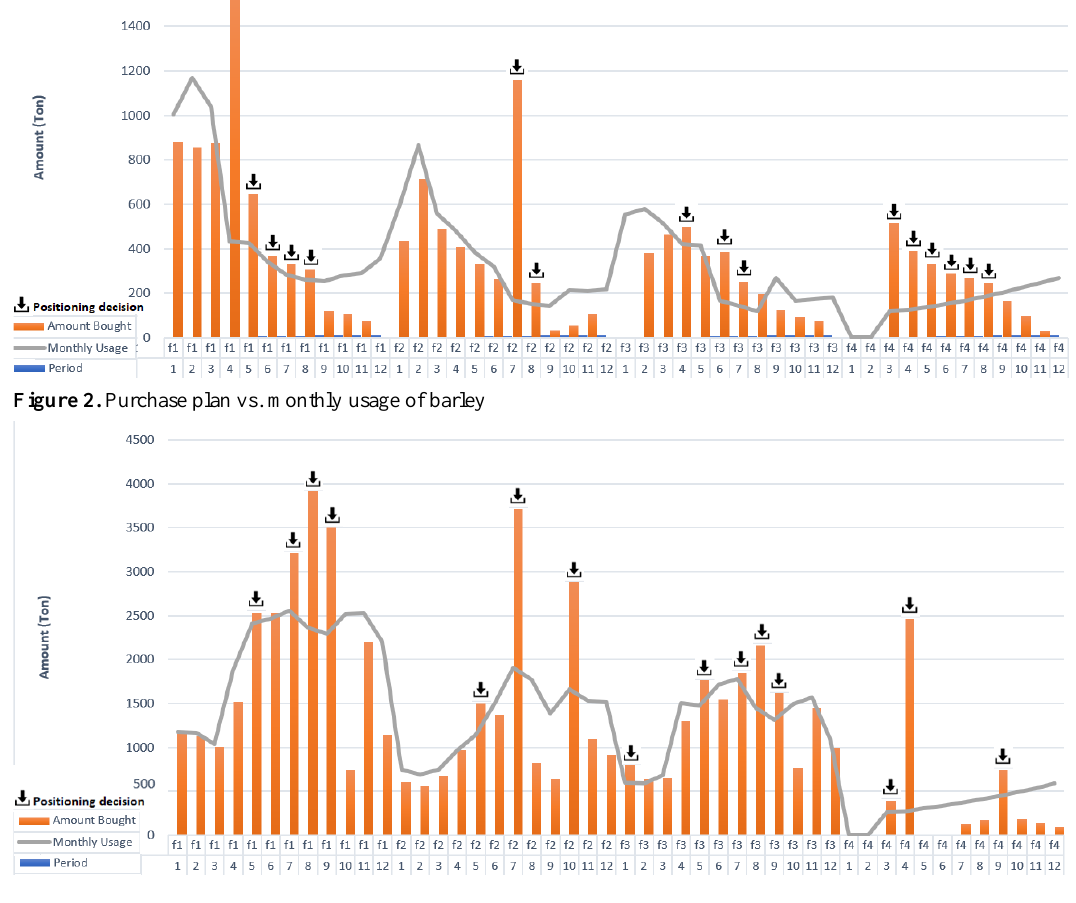
Figure 3. Purchase plan vs. monthly usage of corn